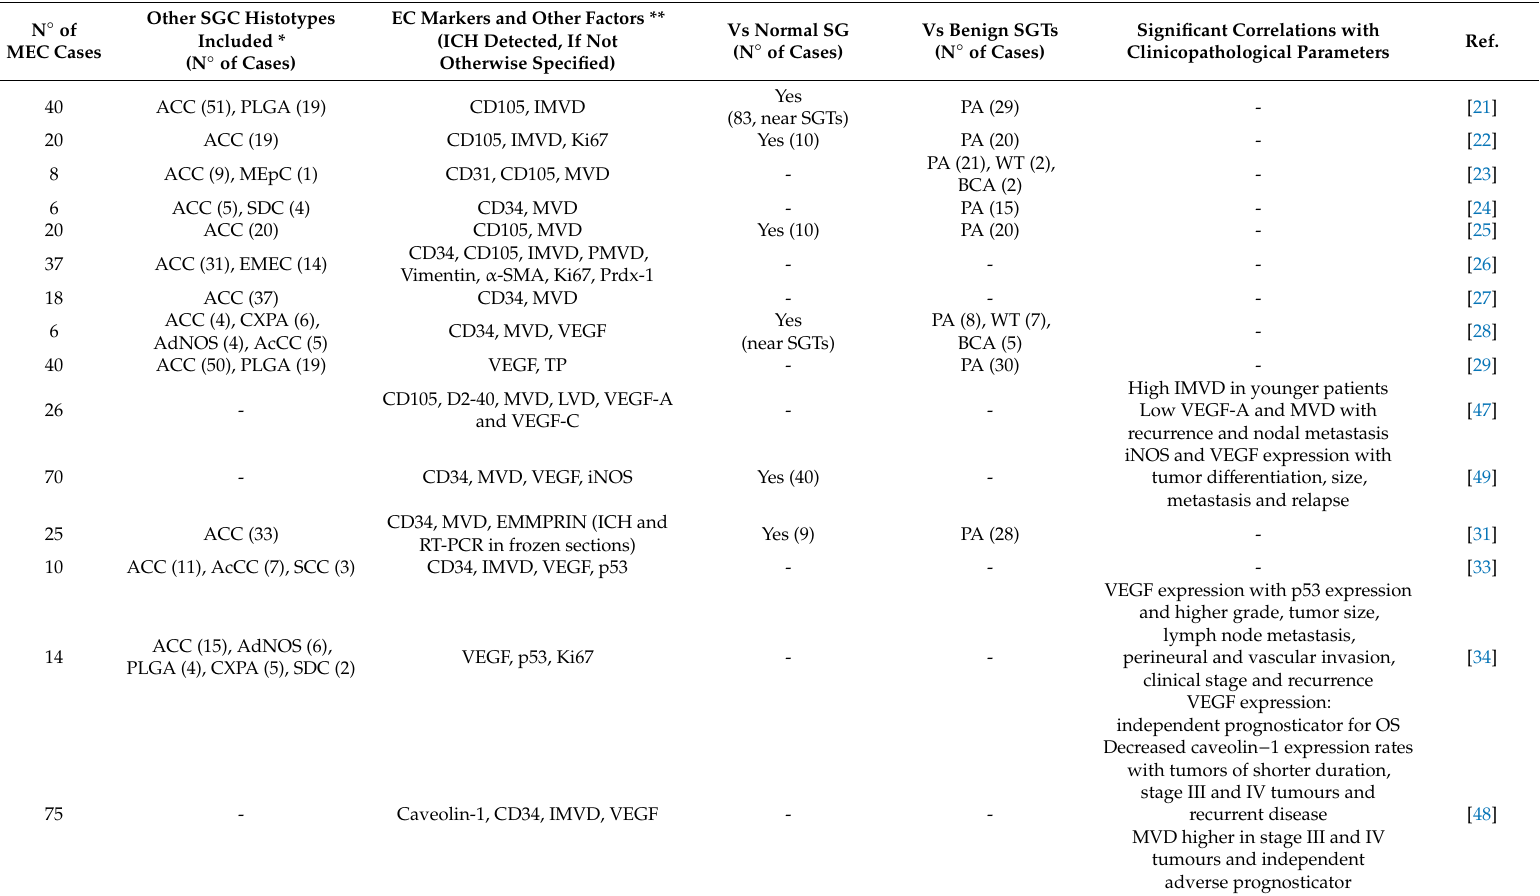
Table 2. Studies investigating the most common factors implicated in Mucoepidermoid carcinoma (MEC)